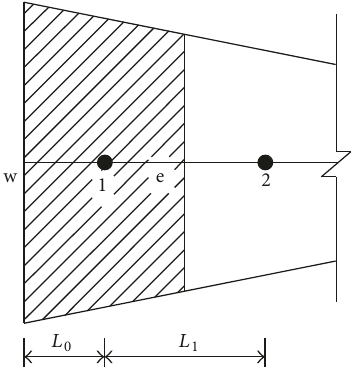
Figure 5: Boundary conditions for fluid injection point.